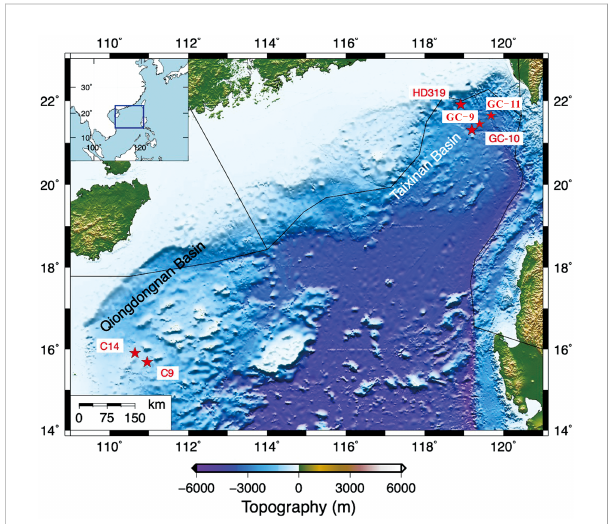
FIGURE 1 Map of study sites and locations in the northern South China Sea. Rectangle boxes denote study areas, which includes the Qiongdongnan basin and Taixinan